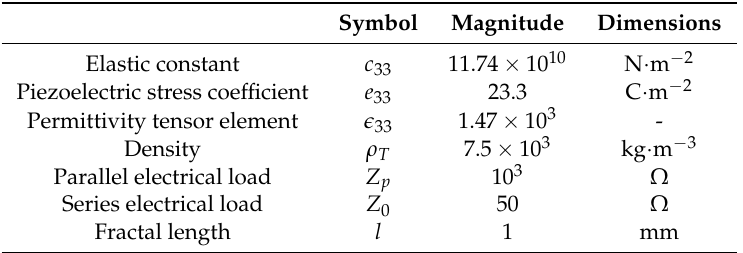
Table 1. Sensor material parameters for a PZT-5H